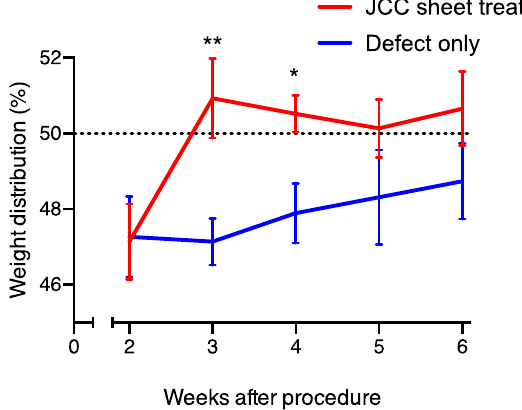
Fig. 7 Rodent weight-bearing test. Weight distribution of rat left and right hind legs are measured, and percentages of treatment side weight bearing are shown. Sample numbers at week 2, 3, 4, 5, and 6 = 13, 12, 12, 8, and 8 (defect only group); = 16, 15, 15, 9, and 9 (defect + CS group), respectively. Data shown as mean and SEM. ** p < 0.01, * p < 0.05 by Welch ’ s t